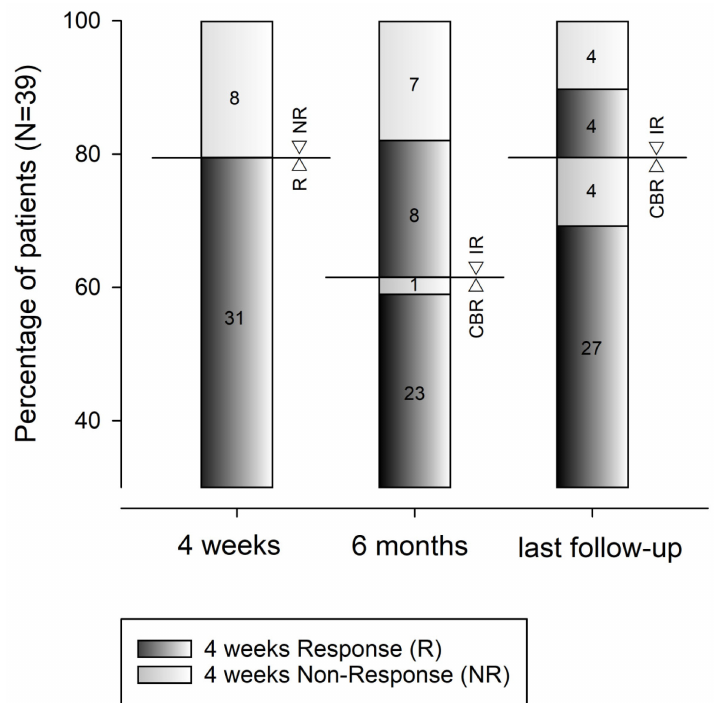
Figure 1. Evolving patterns of responses to immunosuppressive treatment in patients with autoim- mune hepatitis ( n = 39). Horizontal bars and arrowheads delimit the percentages of response. The dark gray histograms (with the number of patients reported inside) show the percentage of patients obtaining the response (R) to treatment, defined as a ≥ 50% decrease from baseline of serum alanine aminotransferase and aspartate aminotransferase levels at four weeks. The light gray histograms (with the number of patients reported inside) show the percentage of patients presenting nonresponse (NR) to treatment, defined as a <50% decrease from baseline of serum alanine aminotransferase and aspartate aminotransferase levels. Complete biochemical response (CBR) and insufficient response (IR) were evaluated both at six months and at the last (IQR) follow-up time of 45 (20–98)